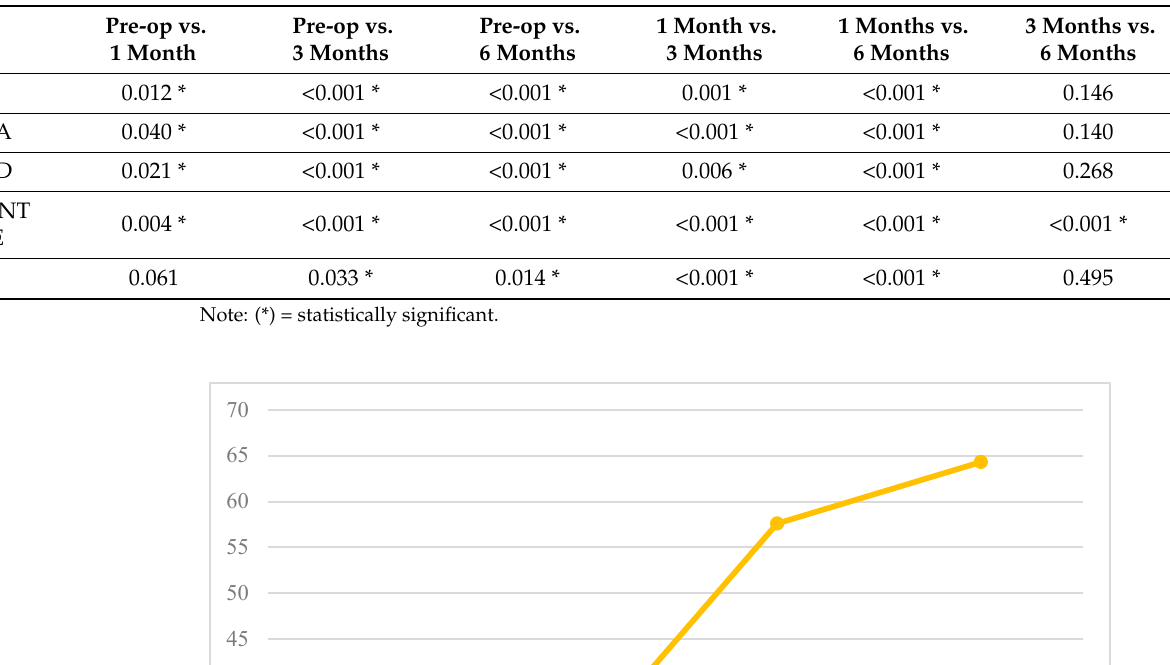
Table 2. Statistically significant differences between preoperative and postoperative time points.